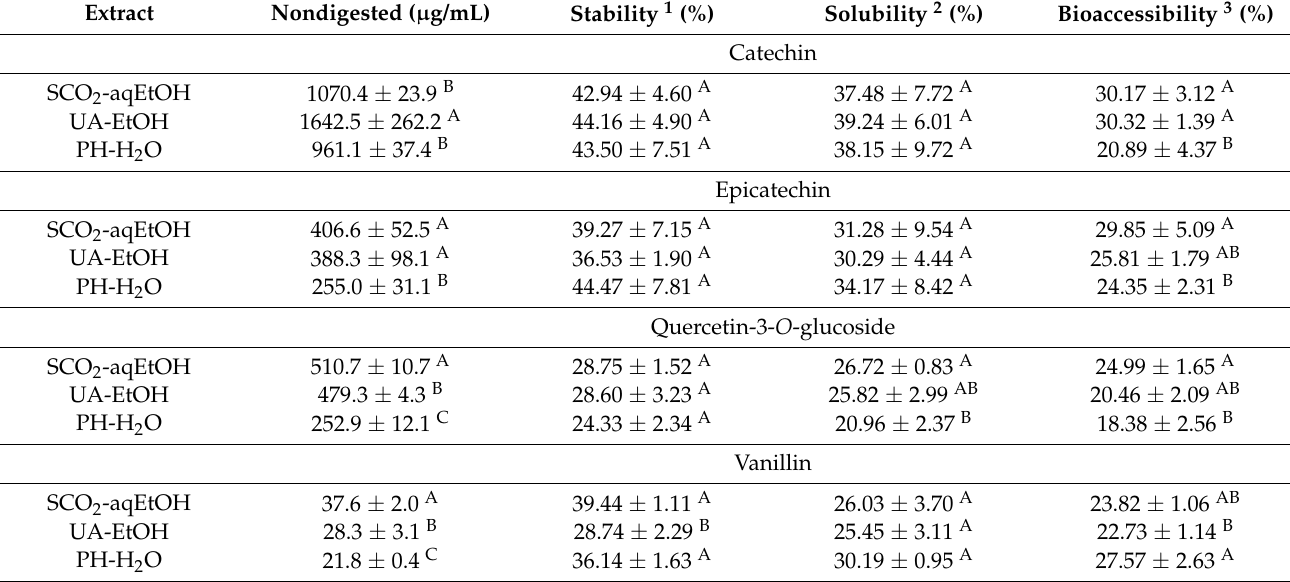
Table 4. In vitro stability, solubility, and bioaccessibility of phenolic compounds from different black rosehip